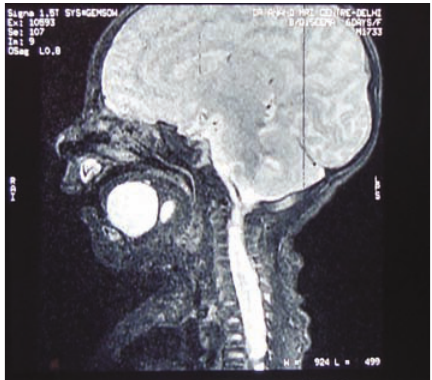
Figure 4: Cyst wall lined by stratified squamous epithelium with presence of mucus glands within the